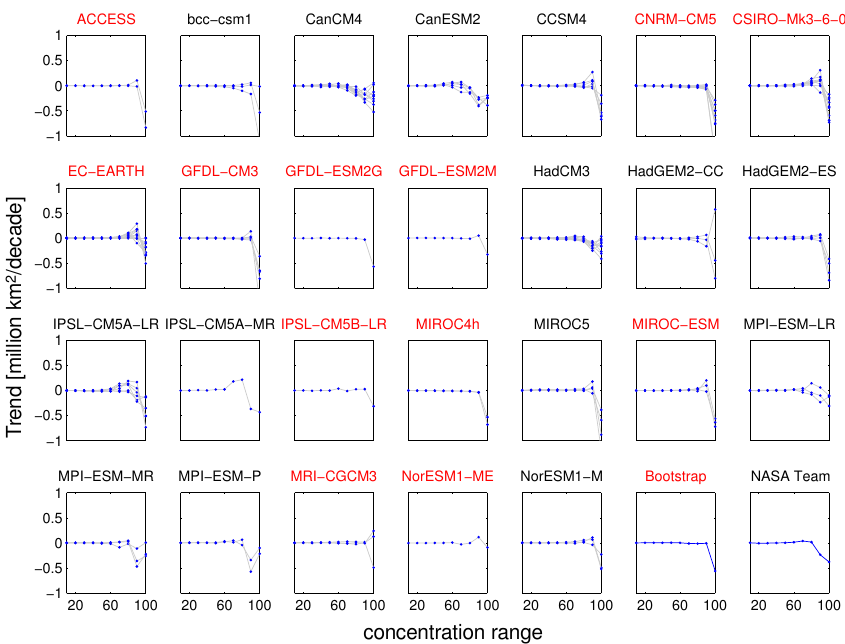
Fig. 8. Trends in September sea-ice area per ice-concentration category. The numbers on the x axis denote the upper limit of each bar: e.g. 20 denotes the concentration range 10 to